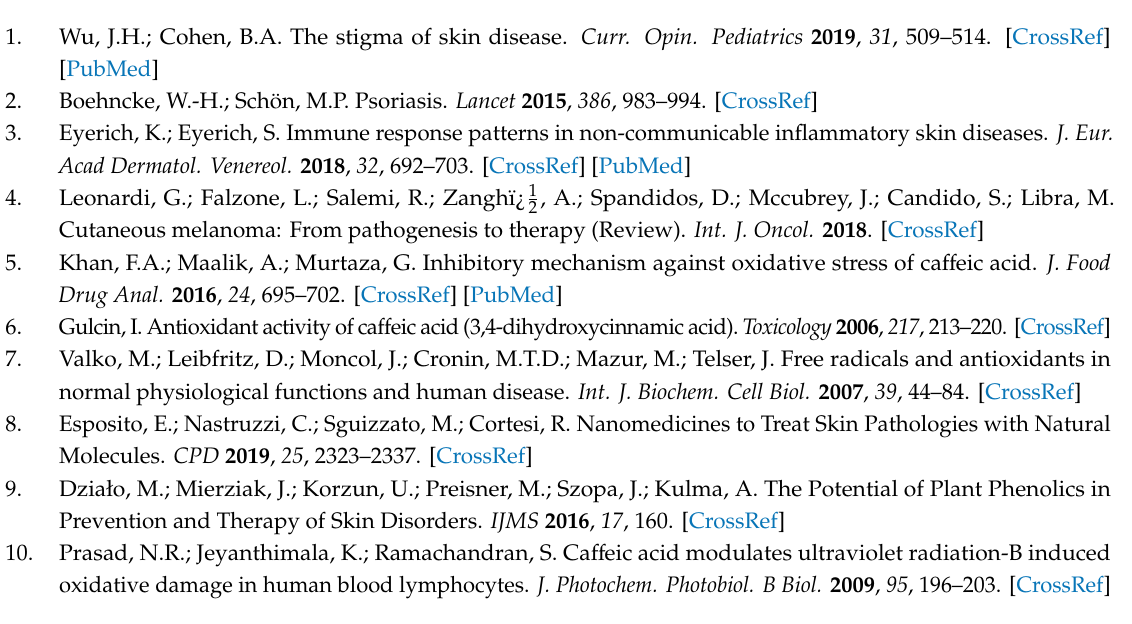
Table S1: Kinetic modelling of stability profile of CA aqueous solution stored for 30 days at di ff erent temperatures, Figure S1: Schematic representation of mechanism of skin covered oxygen